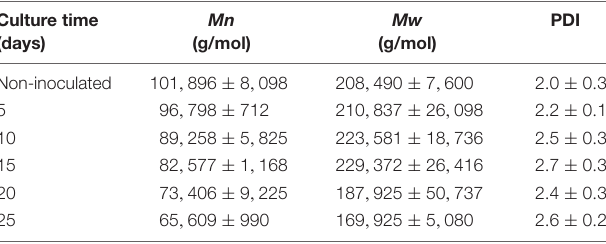
TABLE 1 | Molecular weight and polydispersity index of the PE-PU-A copolymer during cultivation with the BP8 community. Culture